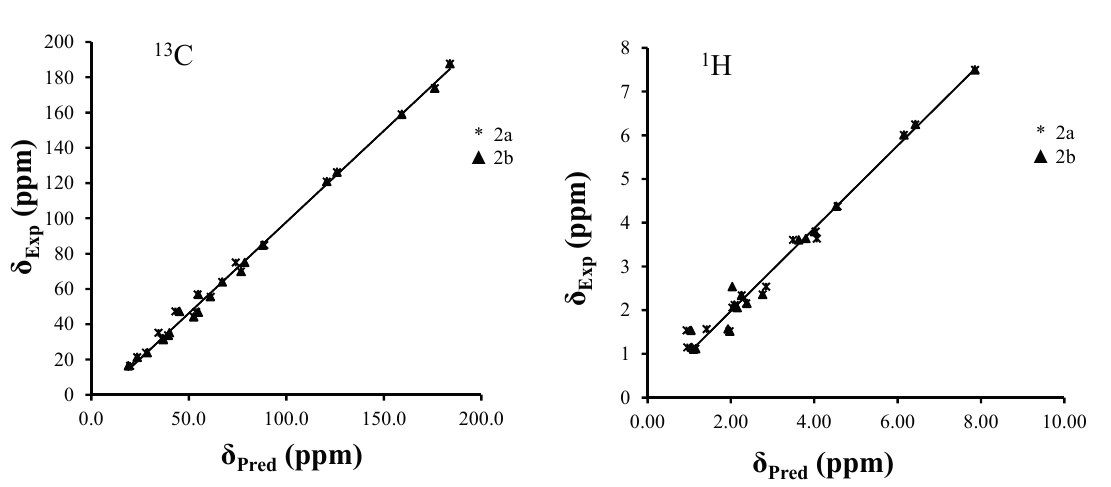
Figure 3. Correlation curves between predicted and experimental chemical shifts of stereoisomers 2a and 2b in